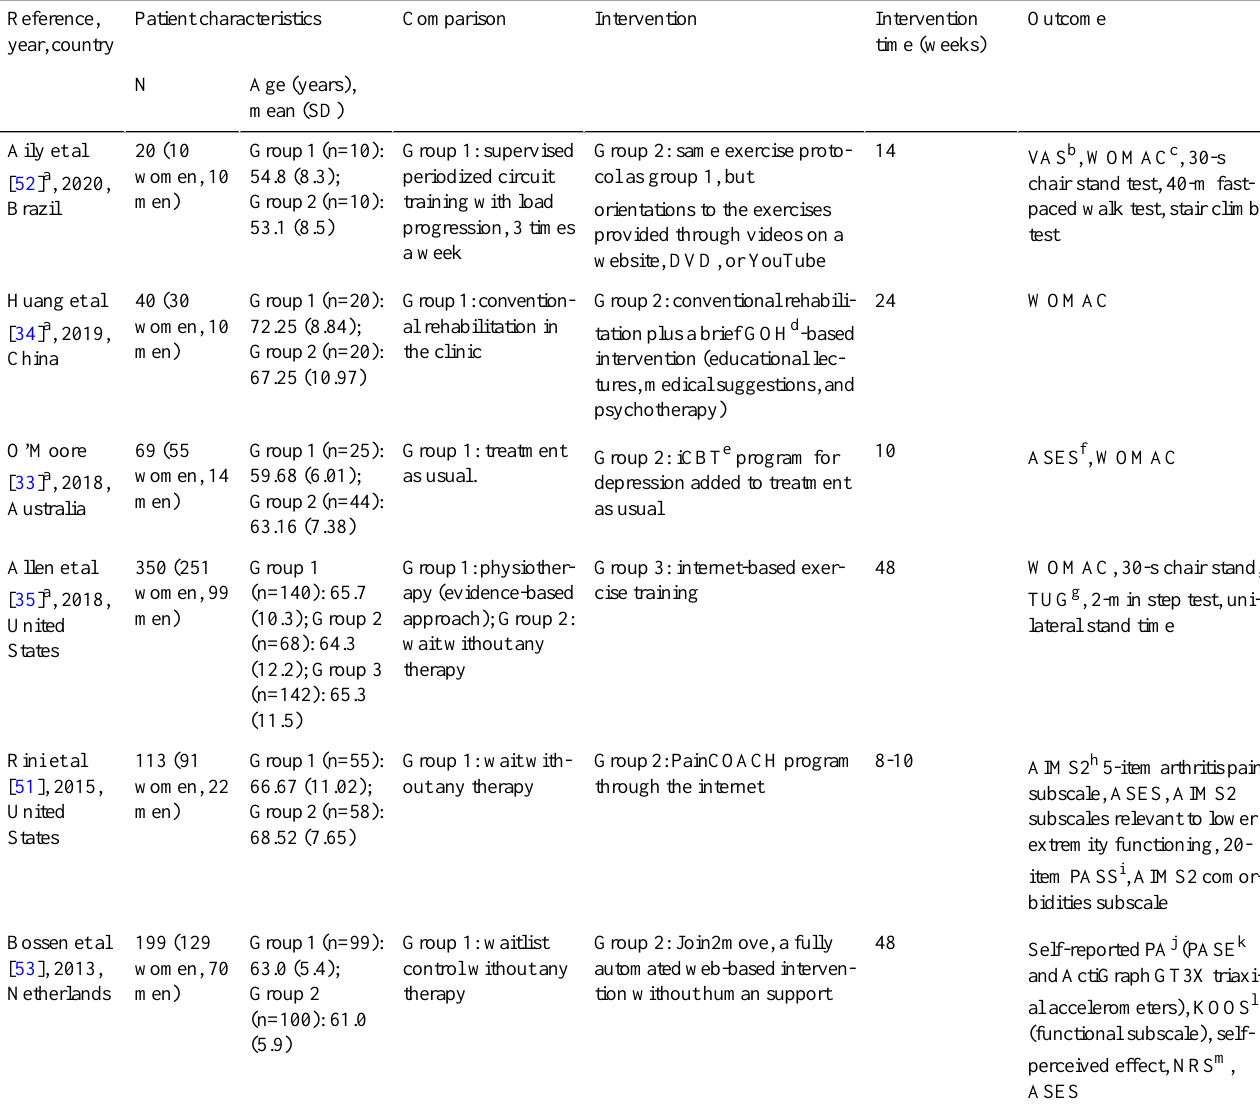
Table 1. Baseline descriptive characteristics of studies included in the systematic review.